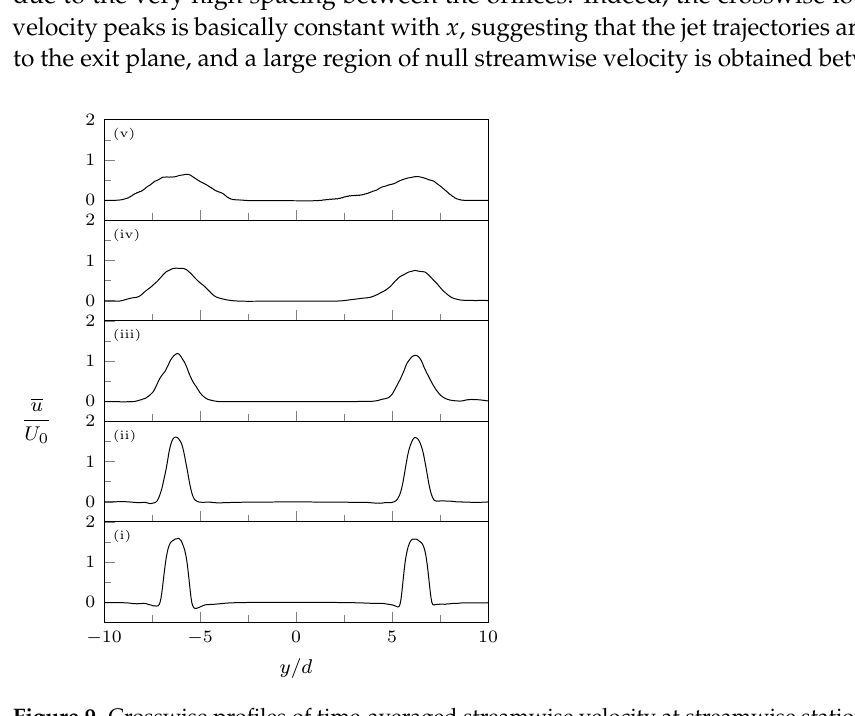
Figure 9. Crosswise profiles of time-averaged streamwise velocity at streamwise stations ( i ) x / d = 1, ( ii ) 2, ( iii ) 4, ( iv ) 6, ( v )